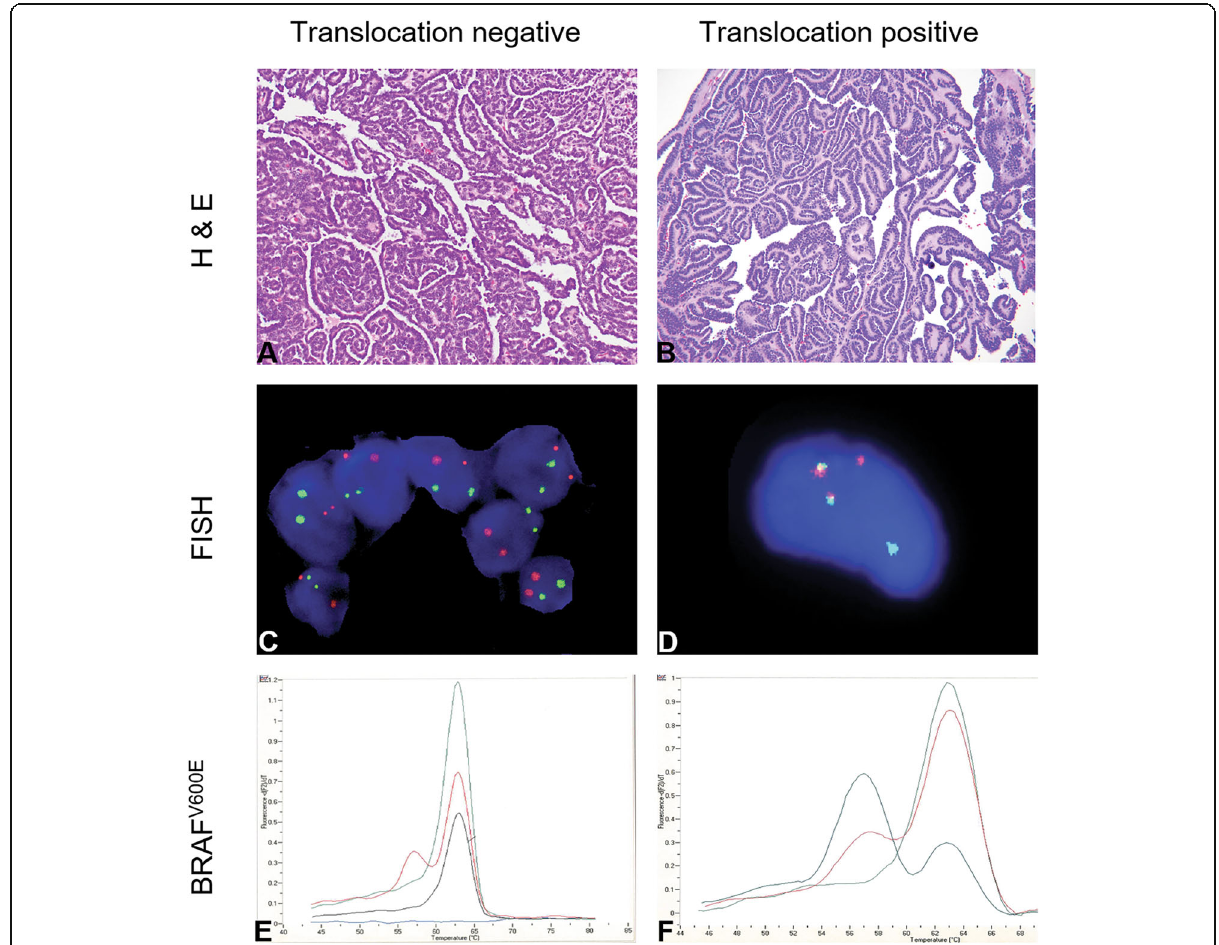
Fig. 1 Histologic, immunohistochemical, fluorescence in situ hybridization and molecular genetic analyses findings of metanephric adenoma. a Hematoxylin and eosin (H&E) of translocation negative metanephric adenoma case, 200x total magnification b H&E slide of translocation positive metanephric adenoma case, 200x total magnification c Fluorescence in situ hybridization with probes for chromosomes 9 (green signal) and 15 (orange/red signal) show normal nuclei with two red and two green signals, (original magnifications 100x) d Abnormal fluorescence in situ hybridization utilizing 2 color probes for the t(9;15) showing one green (9p24) and one orange/red (15q24) signal on the normal homologues. The yellow signals represent the fusion of the probes on the abnormal homologues of chromosome 9p24 and 15q24 (original magnifications 100x) e Melting curve analysis of BRAF mutations in metanephric adenoma sample illustrating a sample without a BRAF GTG > GAC (V600E) mutation of codon 600 (nucleotide 1799) f . Melting curve profiles illustrating the detection of a BRAF V600E mutation of the metanephric adenoma sample with a GTG > GAC (V600E) mutation of codon 600 (nucleotide 1799). Green melting curve represents quality control (QC) wild-type (WT), red melting curve represents QC positive for V600E, black curve represents patient samples (E-non-mutated; F-BRAF V600E mutated) are compared, additional melting peaks or changes in peak-area ratios indicate a sequence alteration under the probe (E and